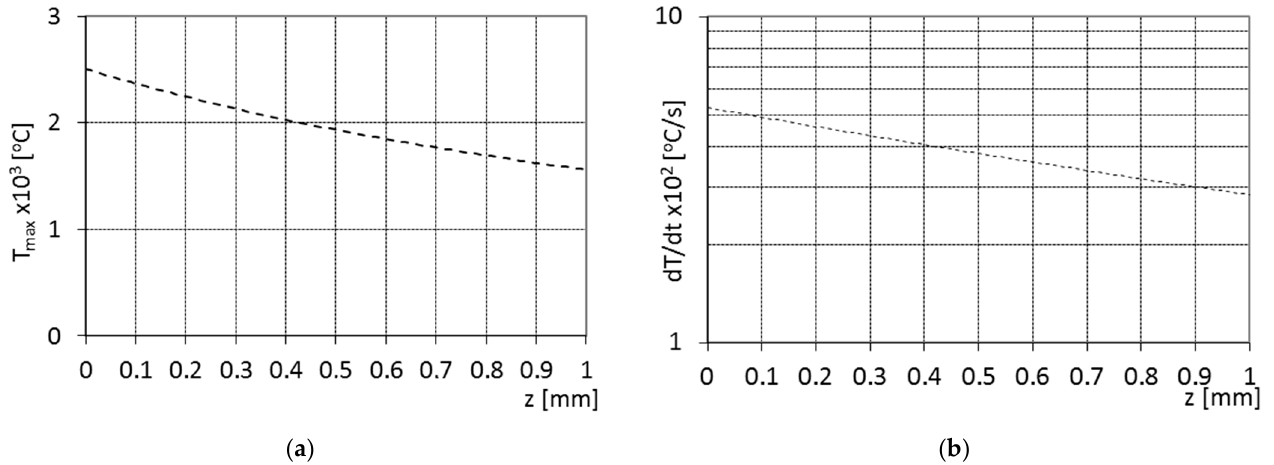
Figure 2. The calculated temperature ( a ) and the cooling rate ( b ) distribution in the distance from the surface to the core material (z) during the laser treatment with the applied laser beam parame- ters.